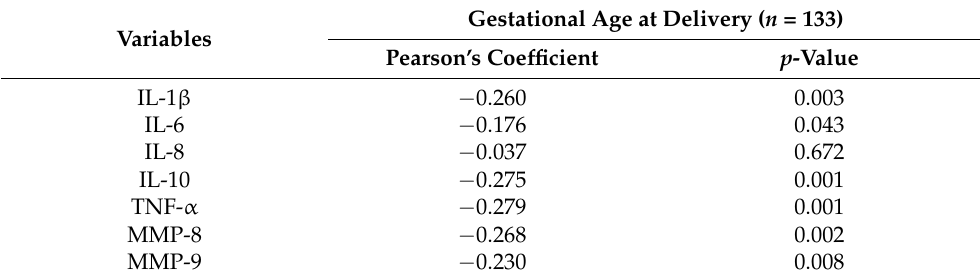
Table 2. Correlation between intraamniotic inflammatory mediators and gestational age at delivery. Variables